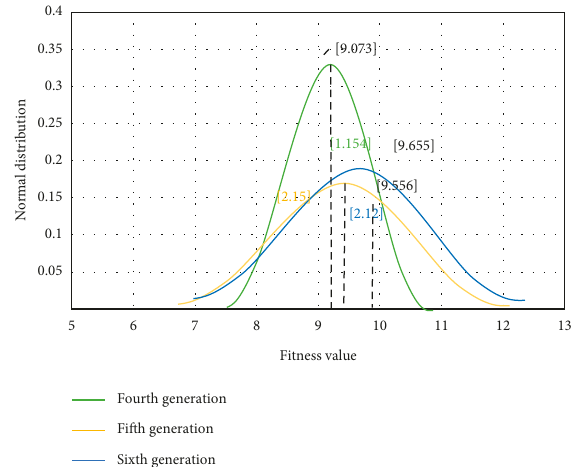
Figure 5: Diversity distribution curve of the “height” values of the sixth-generation sample of test sequence